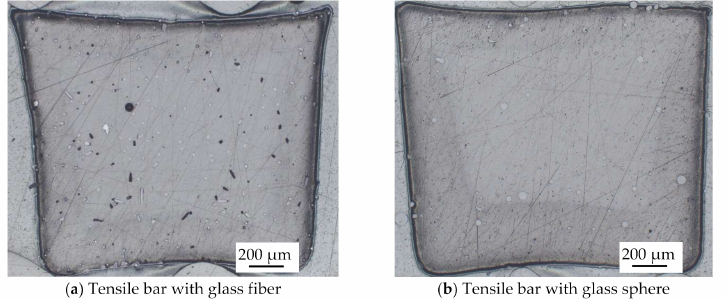
Figure 6. Polarizing microscope image of cured composite resin cross-section area.